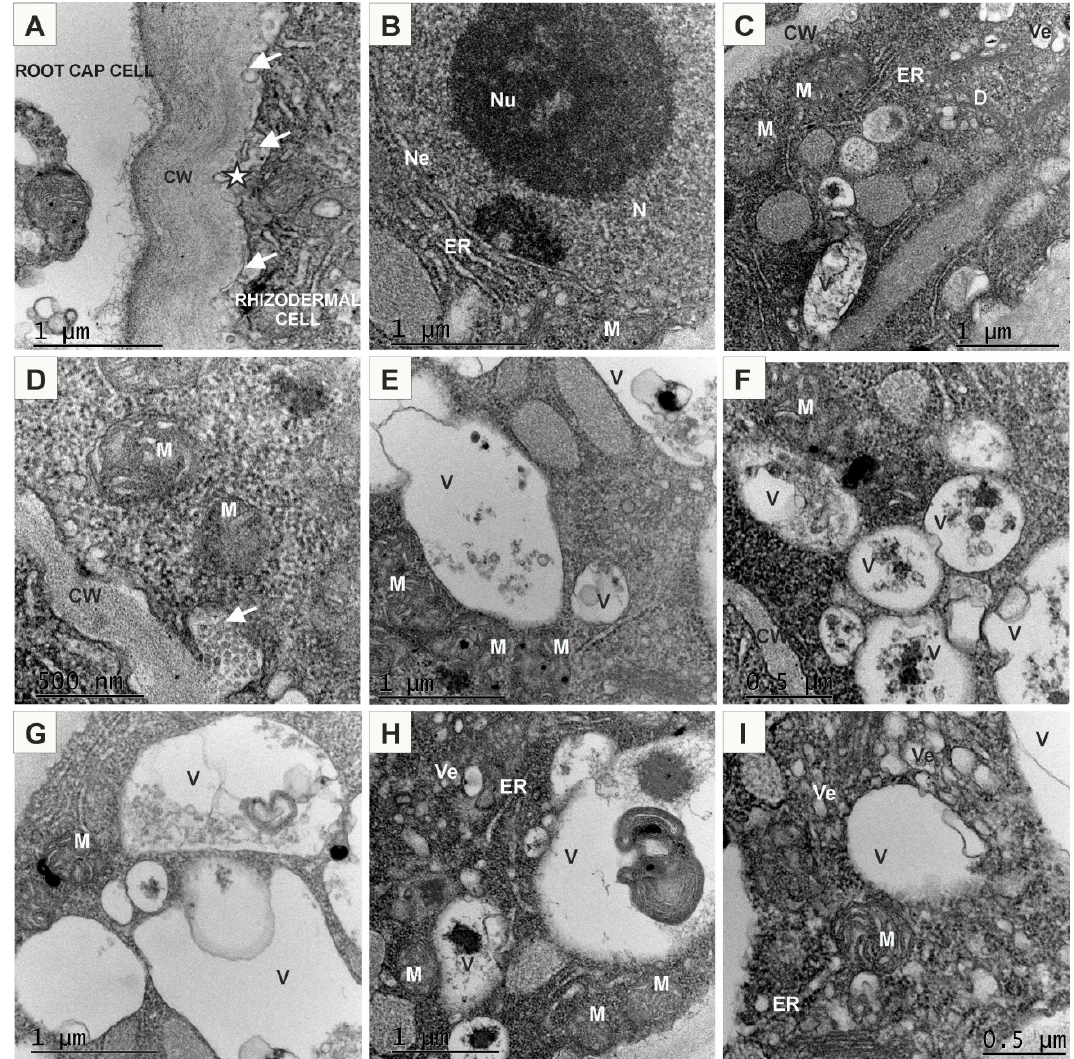
Figure 3. Ultrastructure of rhizodermal cells from the roots treated with (-) AuNPs ( A–I ). CW—cell wall; D—dictyosome; ER—endoplasmic reticulum; L—leucoplast; M—mitochondria; N—nucleus; Ne—nuclear envelope; Nu—nucleolus; Pd—plasmodesmata; V—vacuole; Ve—vesicle; arrows— paramural bodies; asterisk—periplasmic space.